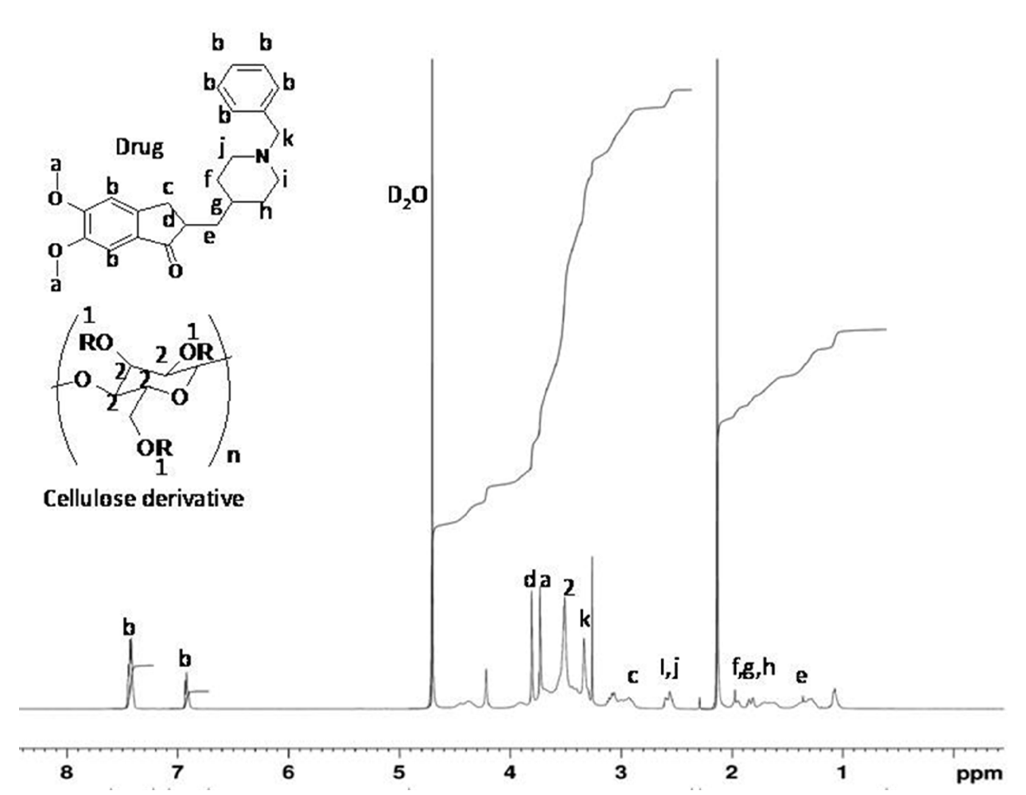
FIGURE 3 - 1 H NMR spectra of cellulose mixed ODF (HPMC-F3).